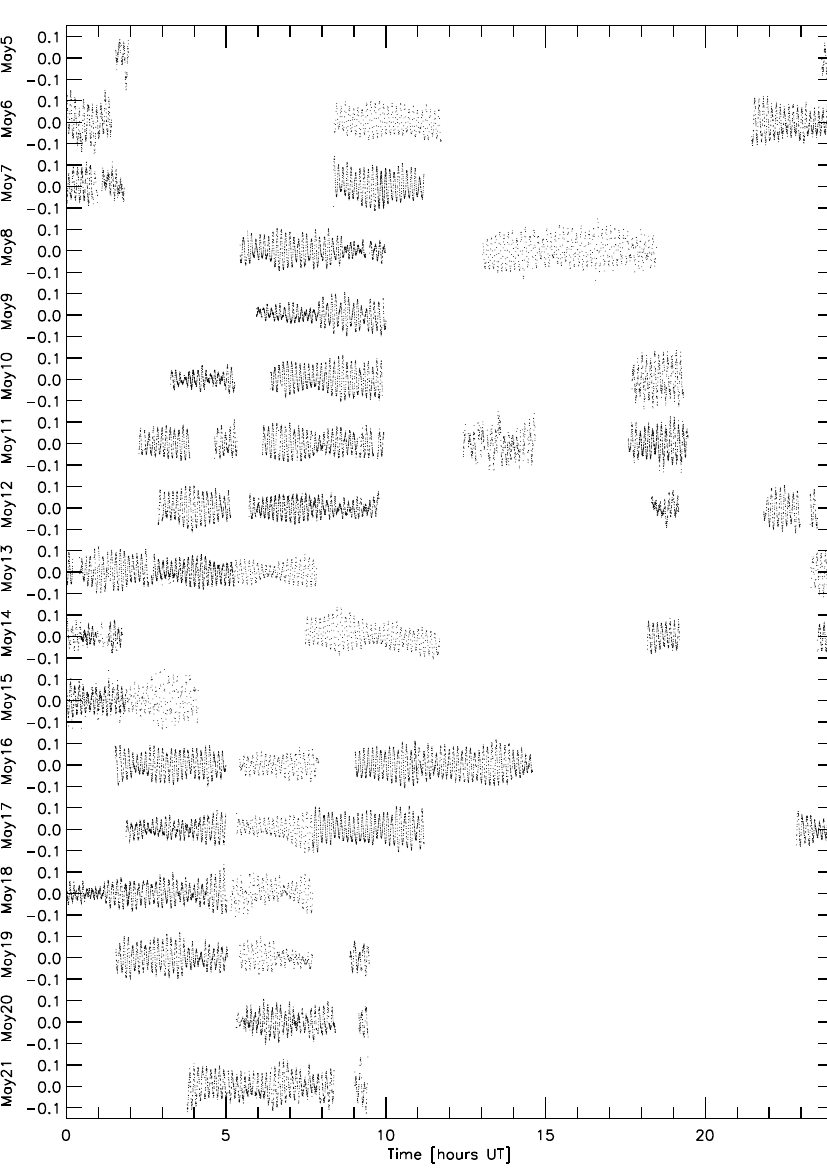
Fig. 1. Overview of the data obtained by the Whole Earth